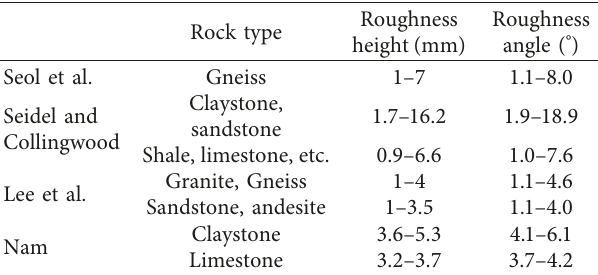
Table 5: Roughness height and angle of borehole